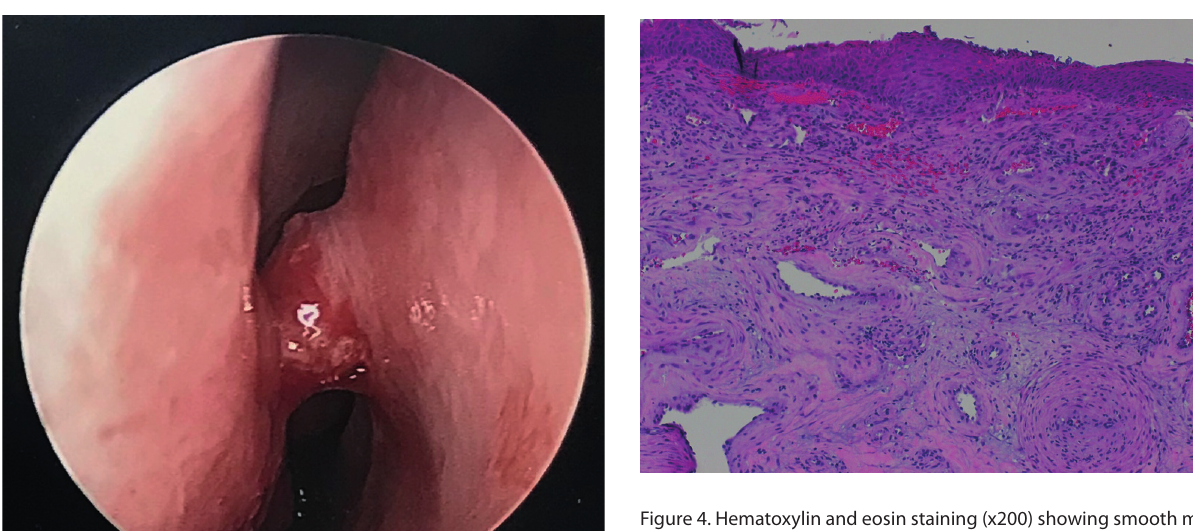
Figure 4. Hematoxylin and eosin staining (x200) showing smooth muscle cell proliferation with thickened blood vessel walls.